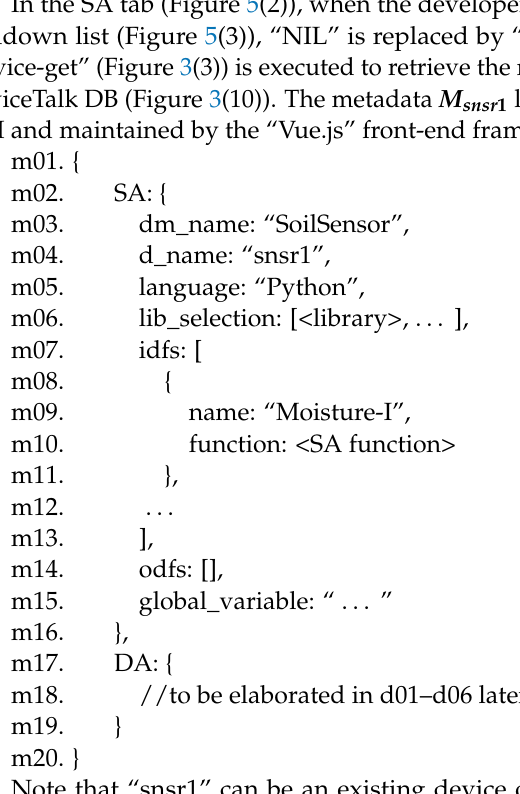
Figure 5. The DeviceTalk GUI.